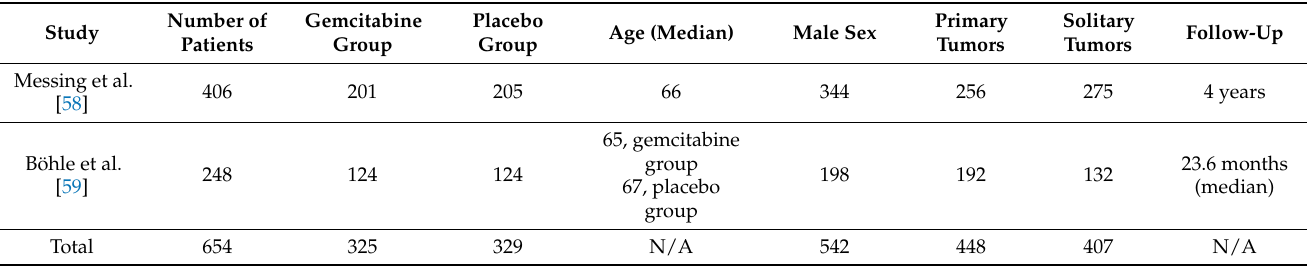
Figure 1. Flowchart depicting the selection process for inclusion of manuscripts in the study. Table 1. Characteristics of each individual study included in the meta-analysis.